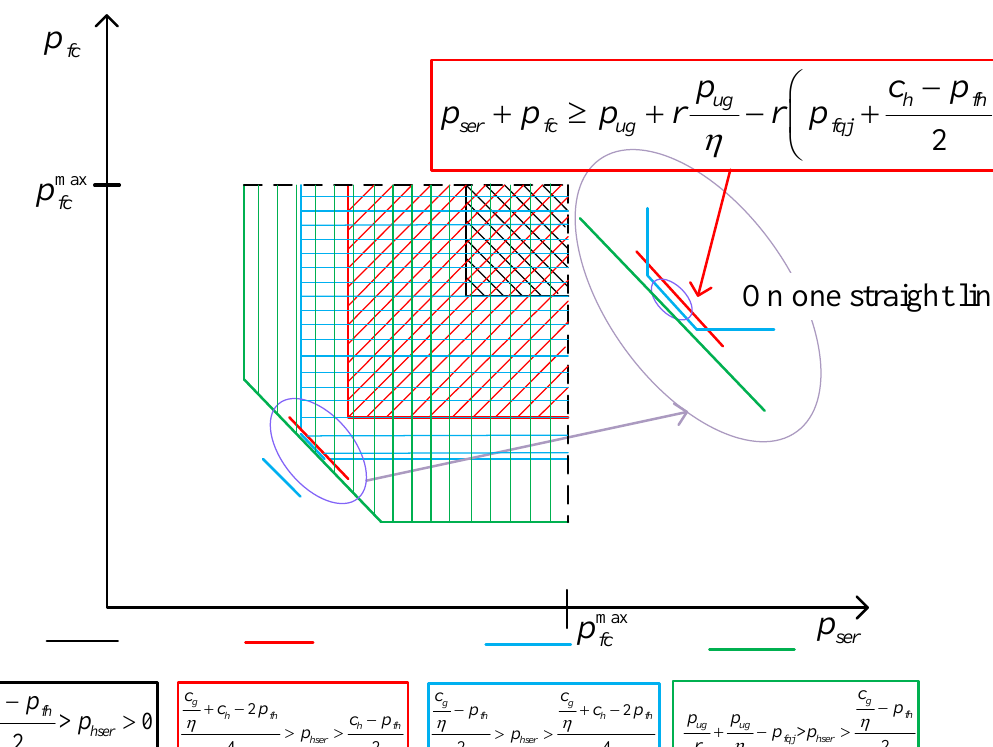
Figure 6. Two-dimensional display of tripartite game Nash equilibria.